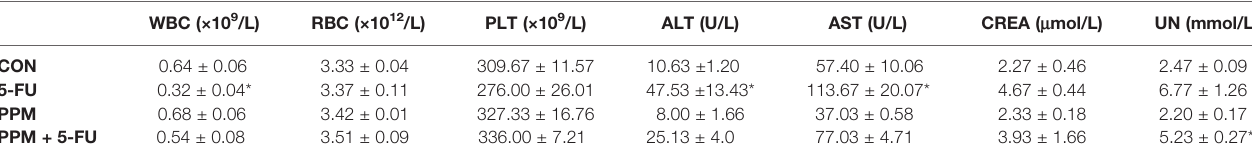
WBC, white blood cell; RBC, red blood cell; PLT, platelet; ALT, alanine aminotransferase; AST, aspartate aminotransferase; CREA, creatinine; UN, urea nitrogen. Data were present as mean±SEM. N=3 per/group. *P < 0.05 vs. CON